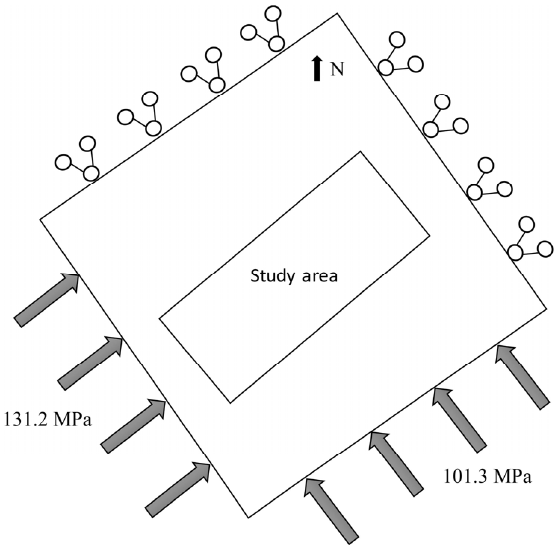
Figure 7. Illustration of the mechanical model for the Pengzhou area during the Himalayan Period.